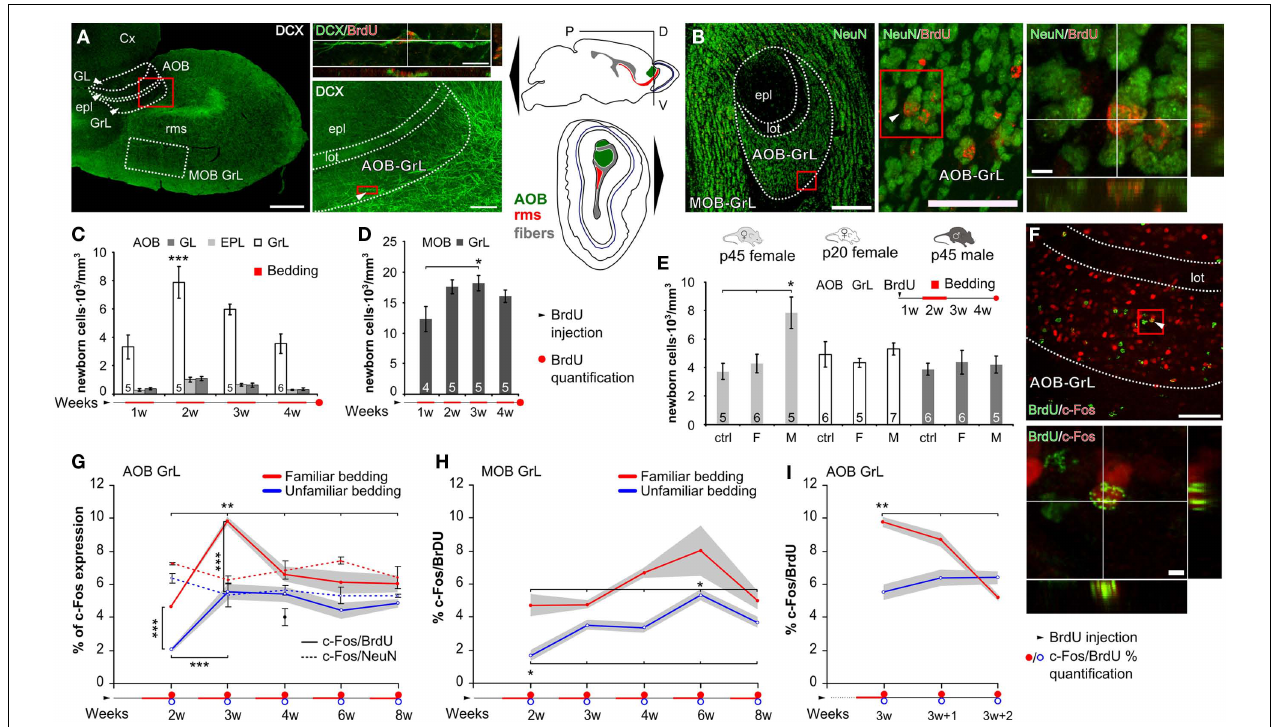
cells in adult females, pre-pubertal females, and adult males evaluated at 28 d.p.i. of BrdU and after 1week exposure to female (F) or male (M) bedding (from 7th to 14th d.p.i. of BrdU). (F) Example of a sagittal AOB section showing c-Fos/BrdU double immunolabeling in the GrL, with a co-labeled cell in the magnified panel ( x : y : z = 1:1:4). (G,H) Percentage of c-Fos/BrdU and c-Fos/NeuN -positive cells induced by familiar and unfamiliar pheromones in AOB–GrL (G) and c-Fos/BrdU in MOB GrL (H) . In (G) the black dot represents the basal levels of c-Fos expression in 4weeks old AOB granule cells. (I) Retention time of newborn AOB granule cell preferential activity. Data are means ± SEM [represented by gray areas in (F–H) ], the numbers in the graph bars indicate the amount of animals used. *P < 0.05, * *P < 0.01, ** *P < 0.001 ( Table 1 ). Bars in (A) : left 500 μ m, right 100 μ m, upper right